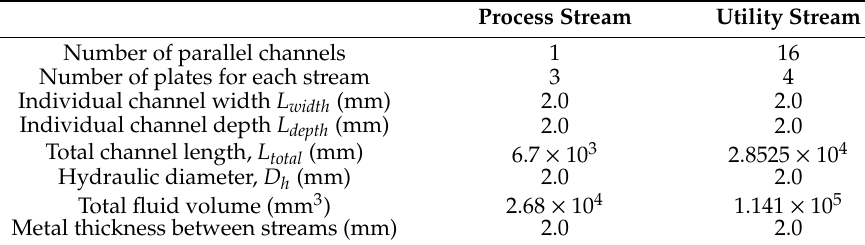
Figure 1. Details of the heat exchanger / reactor: ( a ) Process channel; ( b ) utility channel; ( c ) the heat exchanger / reactor after assembly [9]. Table 1. Geometrical properties of the heat-exchanger / reactor [9].